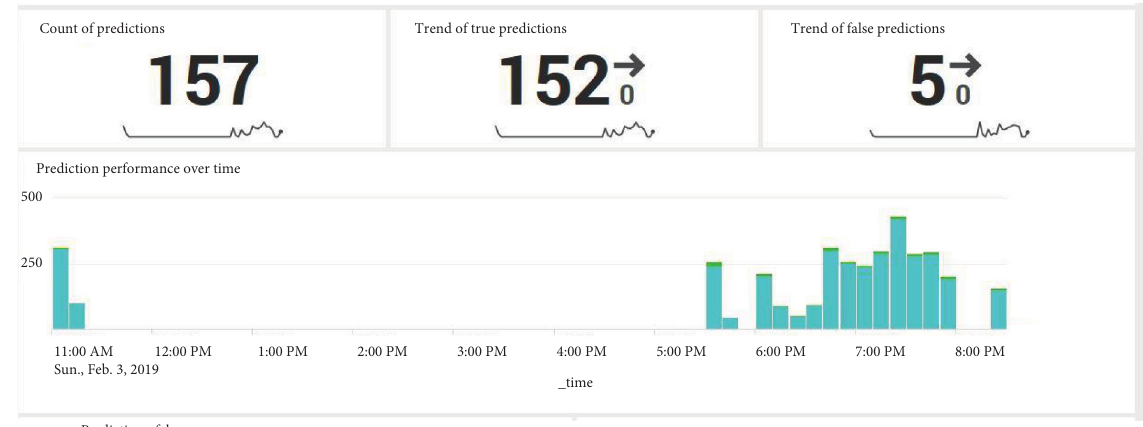
Figure 22: True and false prediction process for SVM algorithm.